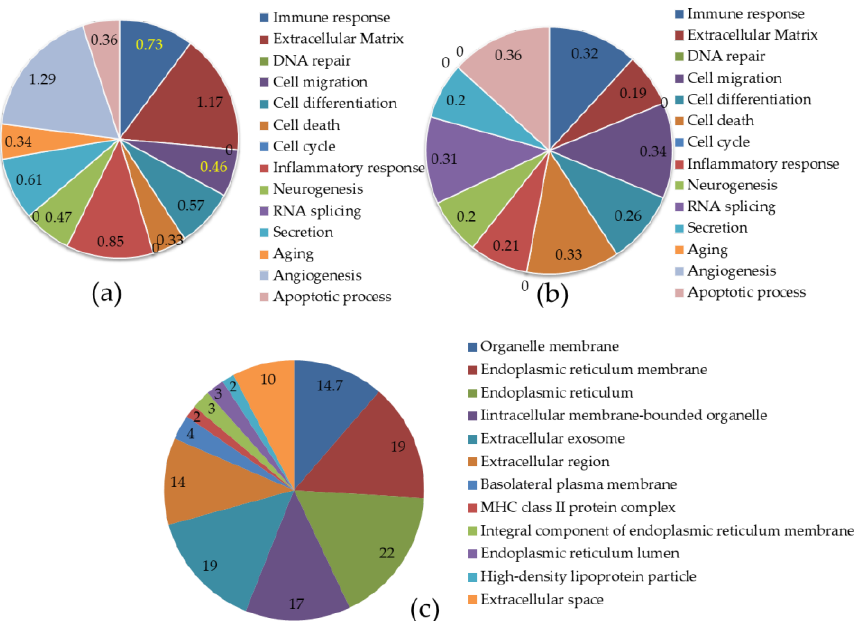
Figure 2. Gene categories and localization of DEGs detected in the liver of experimental animals. ( a ) Gene categorization of identified DEGs in the liver of HFD-fed mice compared to control mice ( p < 0.05, greater than 2-fold); ( b ) Gene categorization of identified DEGs in the liver of HFLPD-fed mice compared to HFD ( p < 0.05, greater than 2-fold); ( c ) distribution of identified DEGs in the liver of experimental animals.